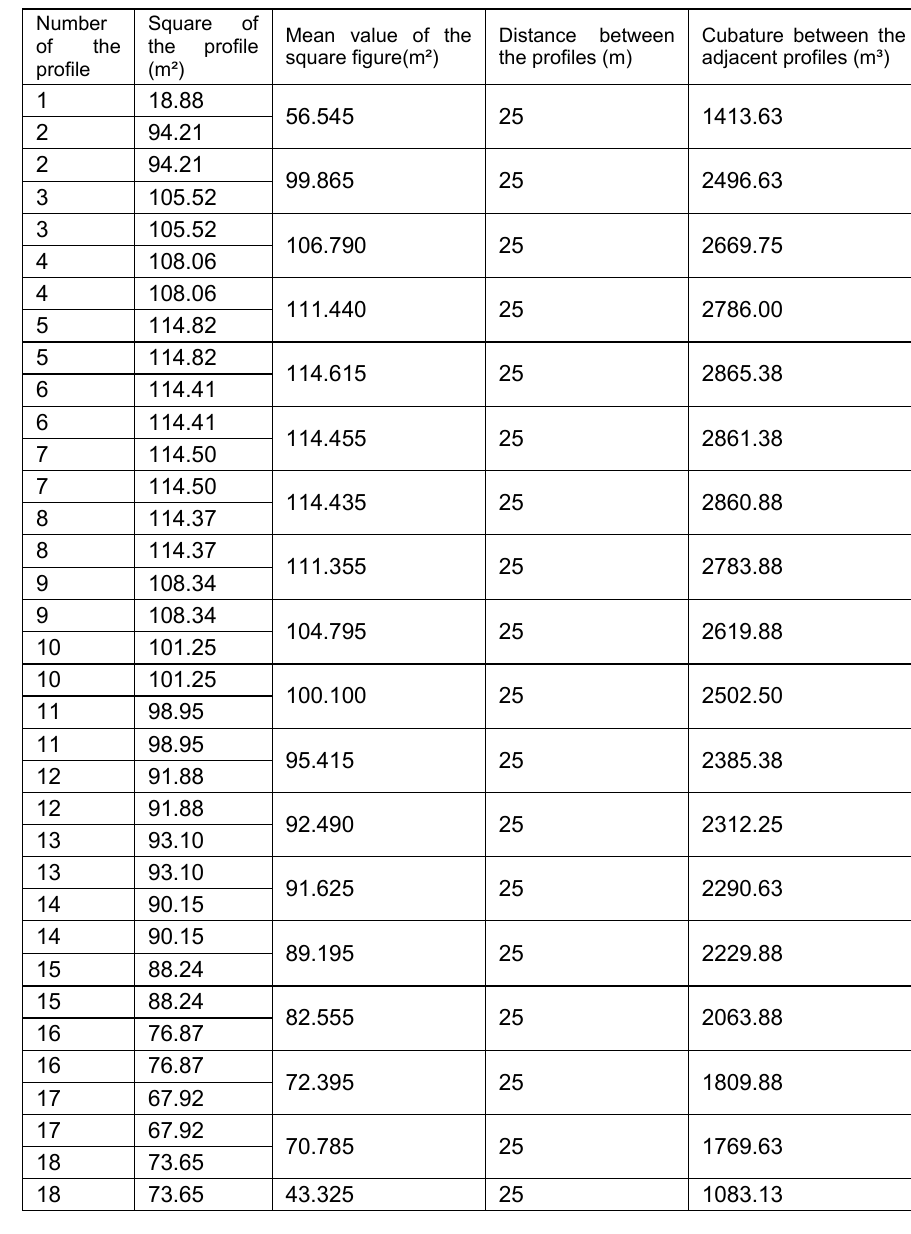
Table 1 – Calculation of the total volume of the excavation based on transversal profiles Таблица 1 – Расчет общего объема карьера на основании поперечных